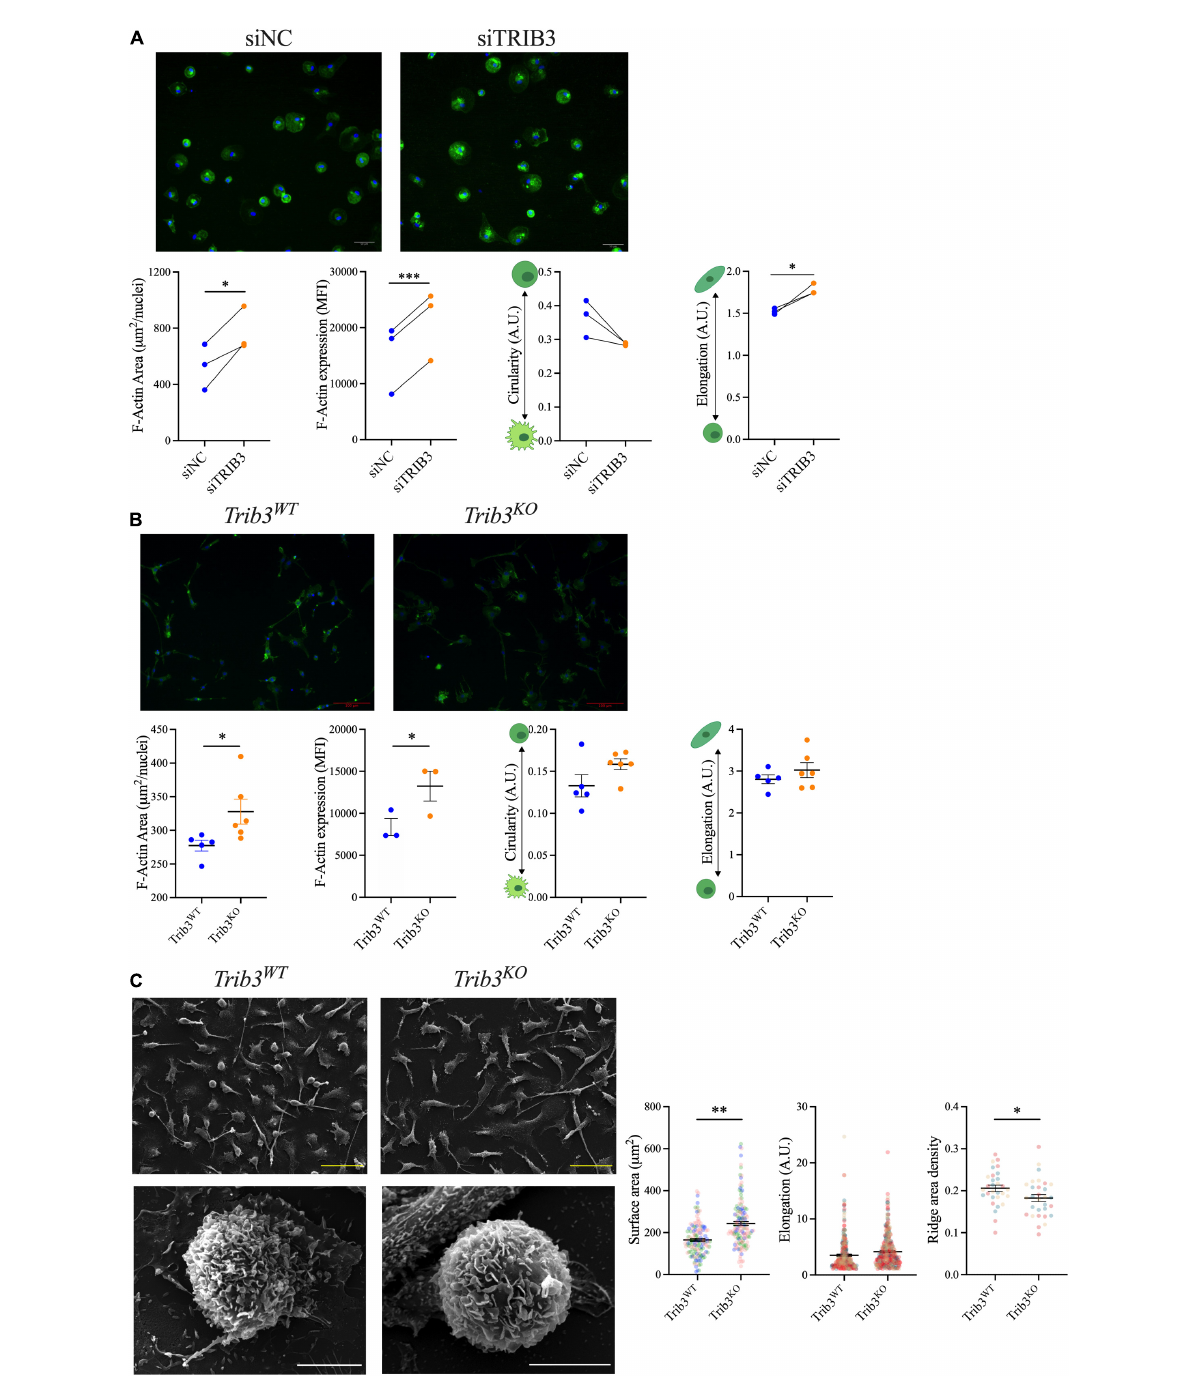
FIGURE6 Increased F-actin and size of macrophages with reduced TRIB3 expression. (A) F-actin staining and quantification of human MDMs with non-targeting or siTRIB3-knockdown; representative images of phalloidin (green) and Dapi (blue) staining (upper) with quantification of cell size (F-actin area), F-actin mean fluorescence intensity and shape descriptors (circularity and elongation), shown connected points for each donor, compared by paired student’s T -test, ∗ p < 0.05, ∗∗∗ p < 0.001. (B) F-actin staining and quantification of Trib3 WT and Trib3 KO BMDMs; representative images of phalloidin (green) and Dapi (blue) staining (upper) with quantification of cell size (F-actin area), F-actin mean fluorescence intensity and shape descriptors (circularity and elongation). Shown as Mean ± SEM where each data point is the average of all cell measurements per individual mouse (3 fields of view per mouse N = 3–6) unpaired student’s t -test, ∗ p < 0.05 (C) Trib3 WT and Trib3 KO BMDMs imaged by scanning EM; quantification of cell surface area, elongation and ridge area density shown as Mean ± SEM where each data point is from an individual cell (3 fields of view per mouse N = 3, 30–60 cells for surface area; 95–148 cells for elongation; 10 cells for ridge density measurements) compared by unpaired student’s T -test, ∗ p < 0.05, ∗∗ p < 0.01. Scale bars represent 100 µ